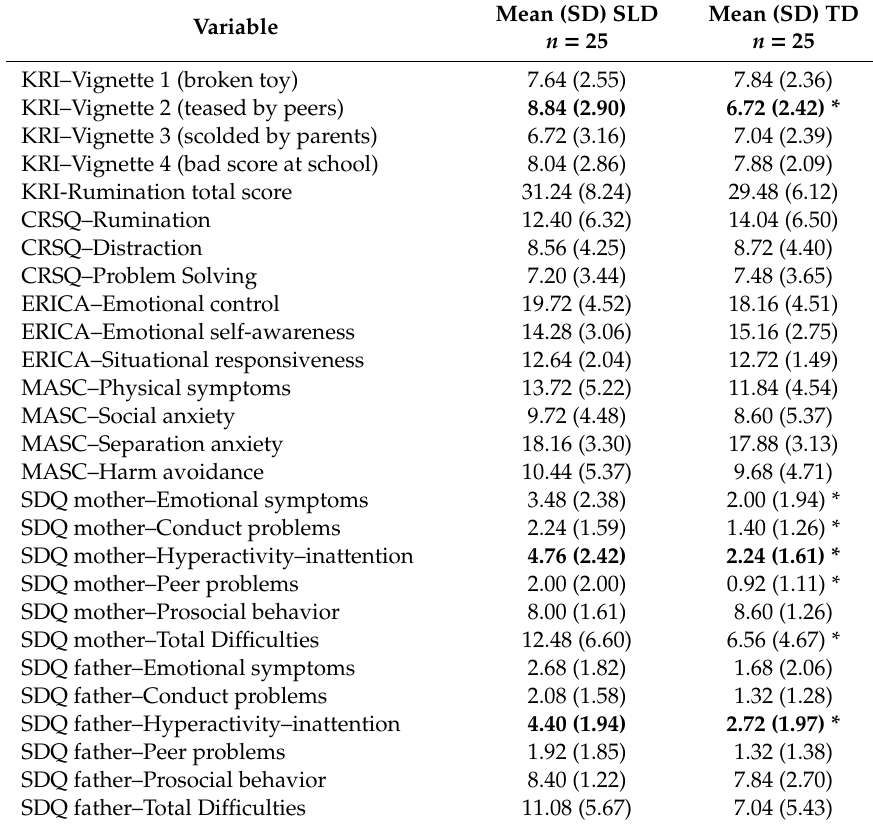
Table 1. Descriptives for children’s variables considering the special learning disorder (SLD) and typically developing (TD)